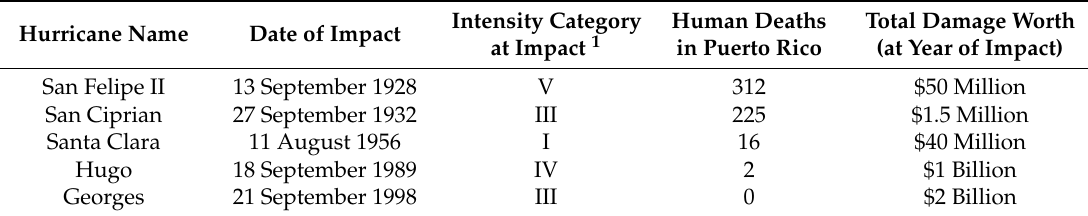
Table 1. Summary of the five most destructive hurricanes passing over Puerto Rico during the 20th century [10].